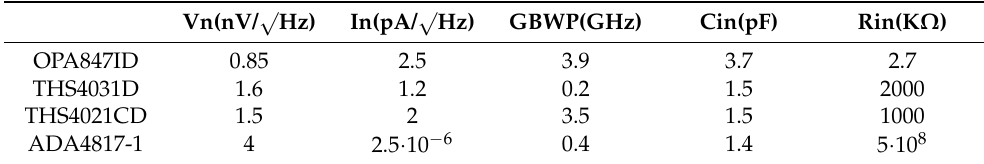
Table 2. Commercial OA characteristic parameters (typical values). Columns from left to right: input